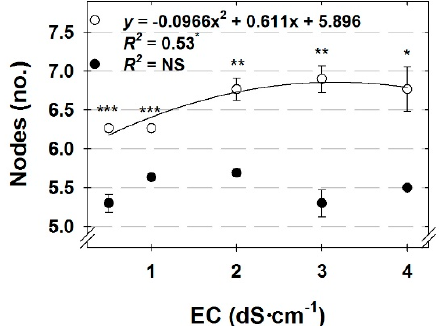
Figure 4. Node number of parsley ( Petroselinum crispum ‘Giant of Italy’) 4 weeks after transplanting into nutrient-film technique hydroponic systems in a greenhouse under a low (~7 mol·m − 2 ·d − 1 ; closed symbol) or high (~18 mol·m − 2 ·d − 1 ; open symbol) daily light integral (DLI) with a range of nutrient solution electrical conductivity (EC; 0.5 to 4.0 dS·m − 1 ) treatments. Each symbol represents the mean of three replications with ten plants per replicate, and error bars represent the standard errors of the mean of the three replicates. NS or * indicate non-significant or significant at p ≤ 0.05, respectively.